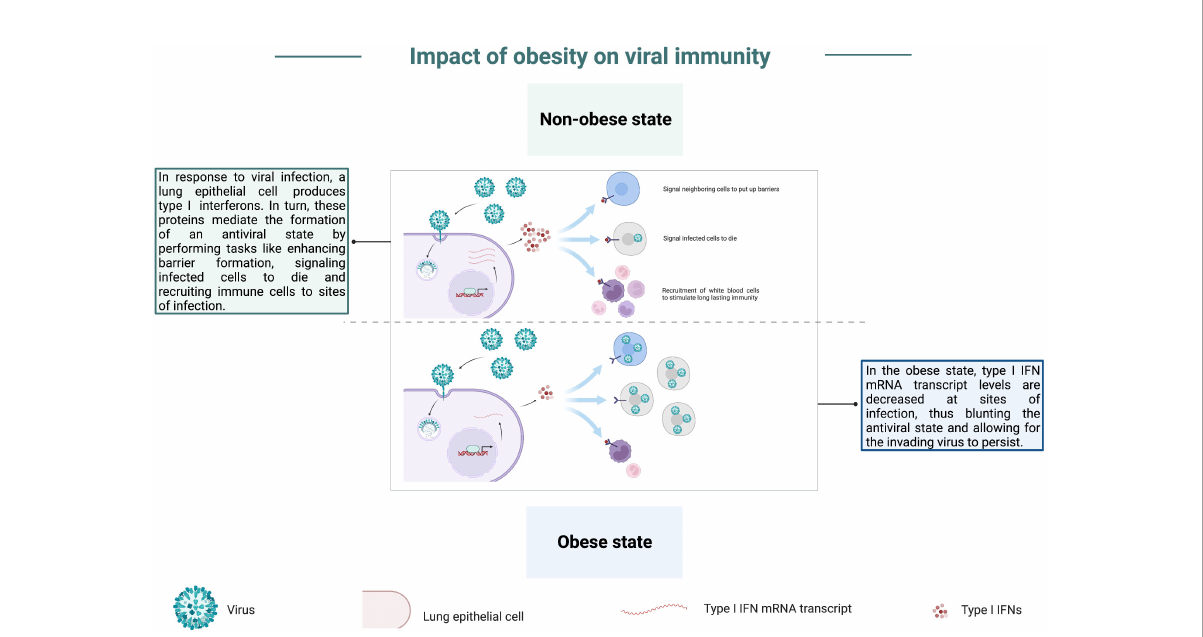
FIGURE 5 Obesity blunts anti-viral type I IFN responses. In the non-obese state, a lung epithelial cell produces type I interferons (type I IFNs) in response to infection by a respiratory pathogen. In turn, these proteins mediate the induction of an antiviral state through tasks such as enhancing barriers, signaling infected cells to die, and recruiting immune cells to infection sites. In the obese state, mRNA transcripts of type I IFNs are decreased at infection sites, thus blunting the induction of an antiviral state and allowing the invading virus to